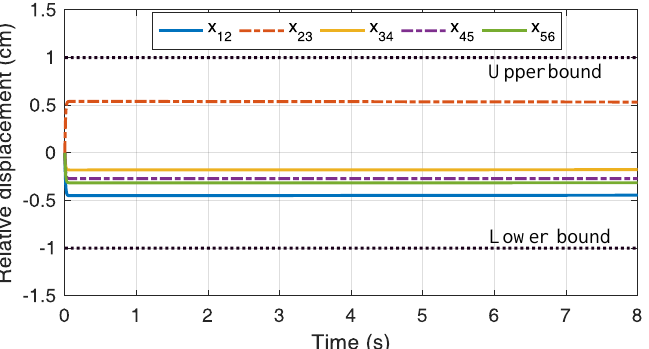
Figure 4. Relative displacement curve of each carriage with the proposed consensus braking controller in case 1.